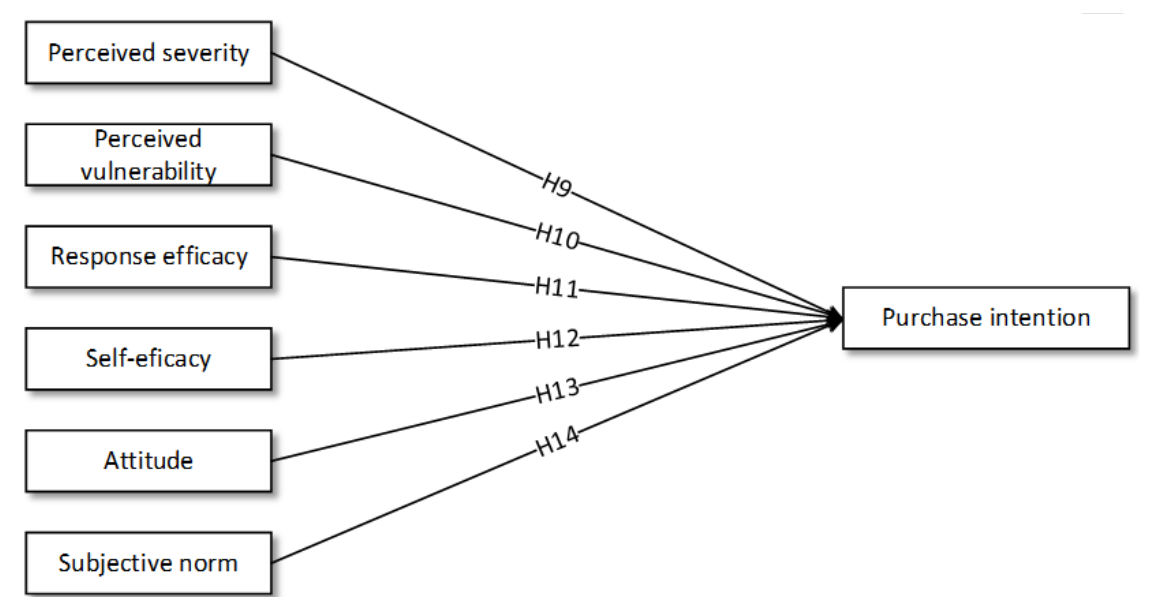
Figure 2. Multi-theoretical approach and purchase intention (H9 –